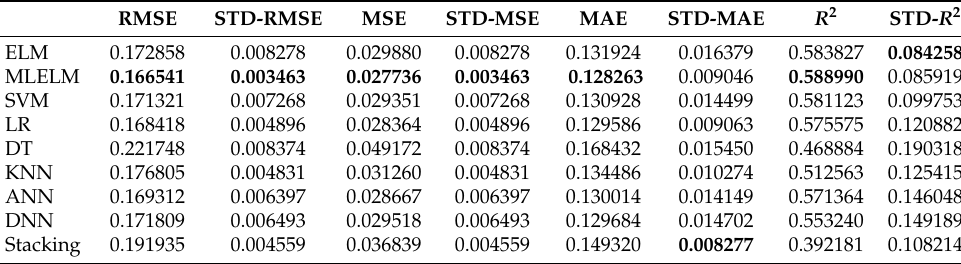
Table 2. The performance of various models for annual building energy consumption: tenfold division.